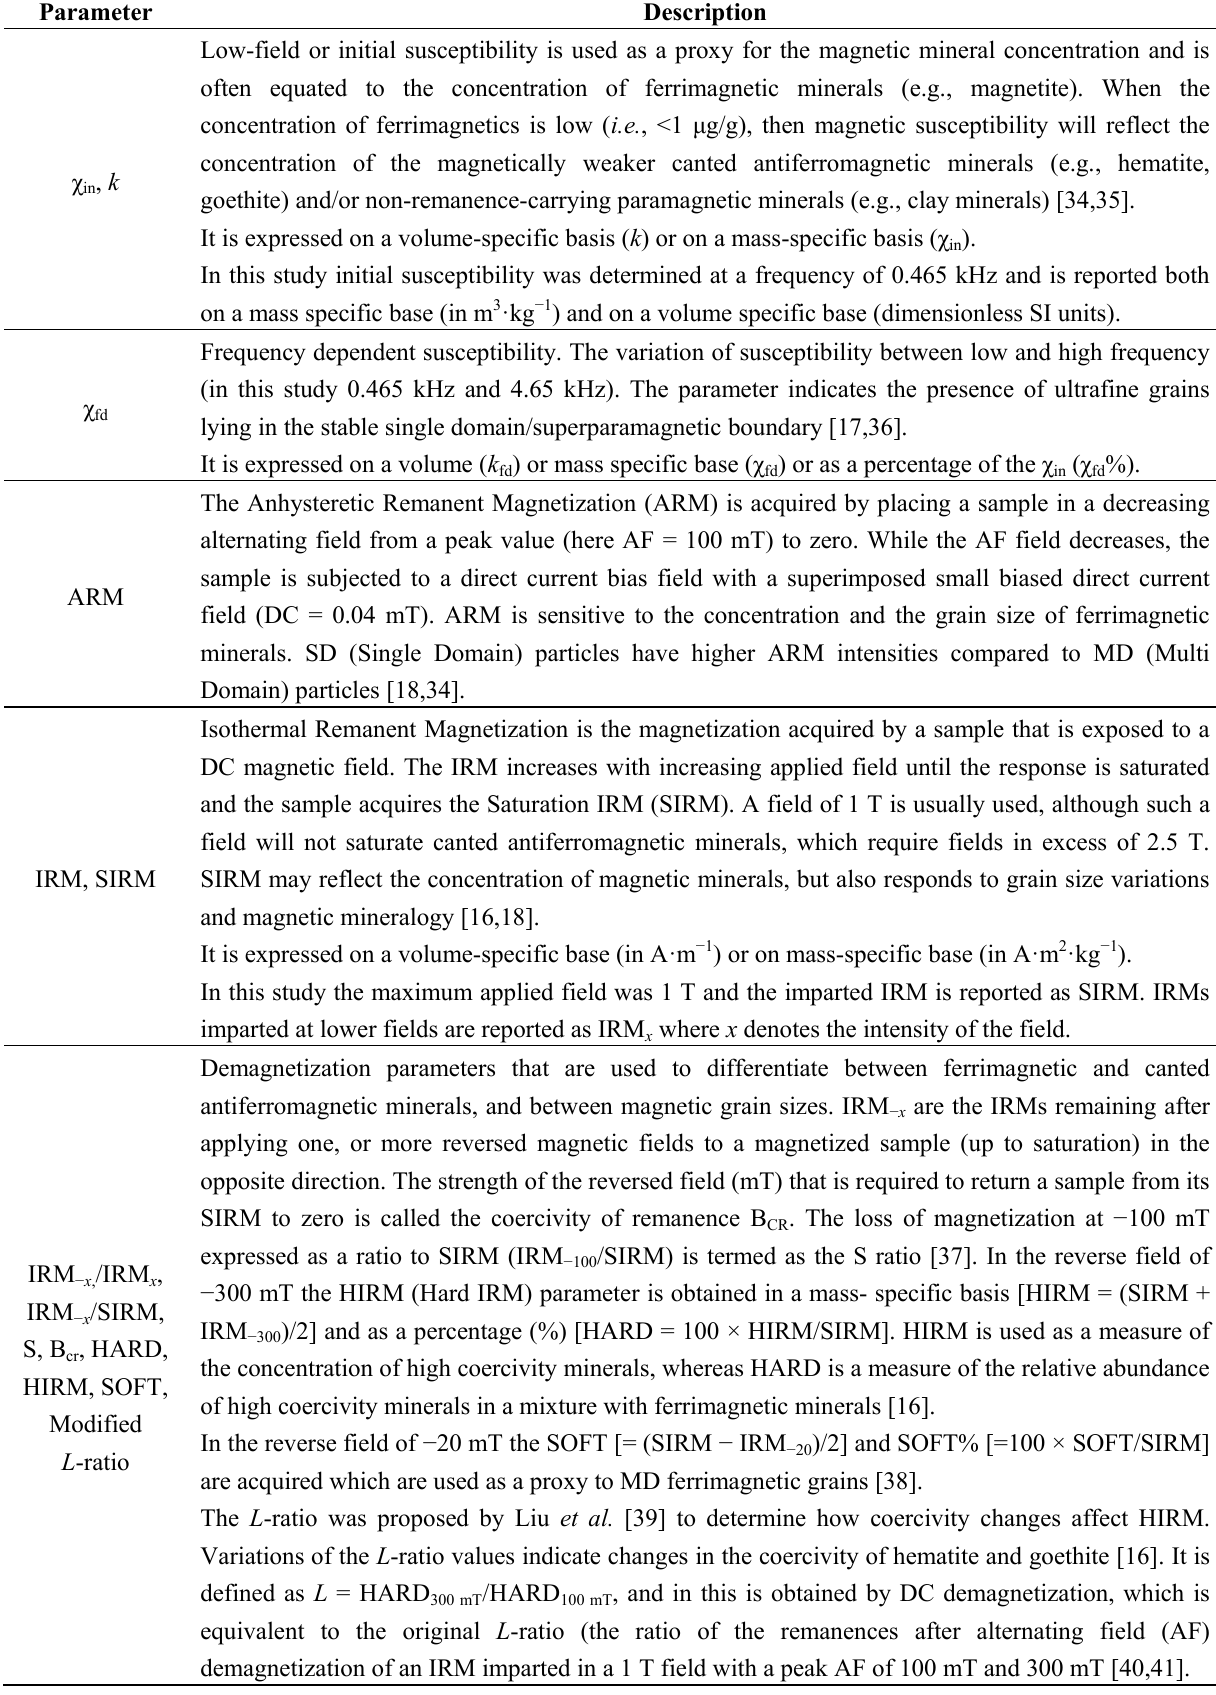
Table 2. Mineral magnetic